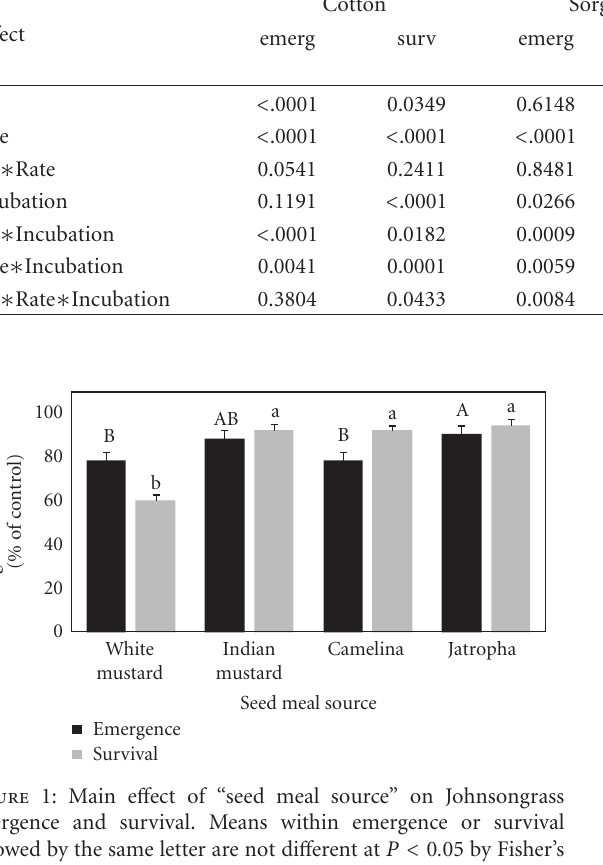
Figure 2: Interactive e ff ects of “seed meal type and rate” on Johnsongrass emergence and survival. Means followed by the same letter are not di ff erent at P < 0 . 05 by Fisher’s protected LSD. Uppercase letters separate emergence means and lowercase letters separate survival means. Data are means (four replications) ±